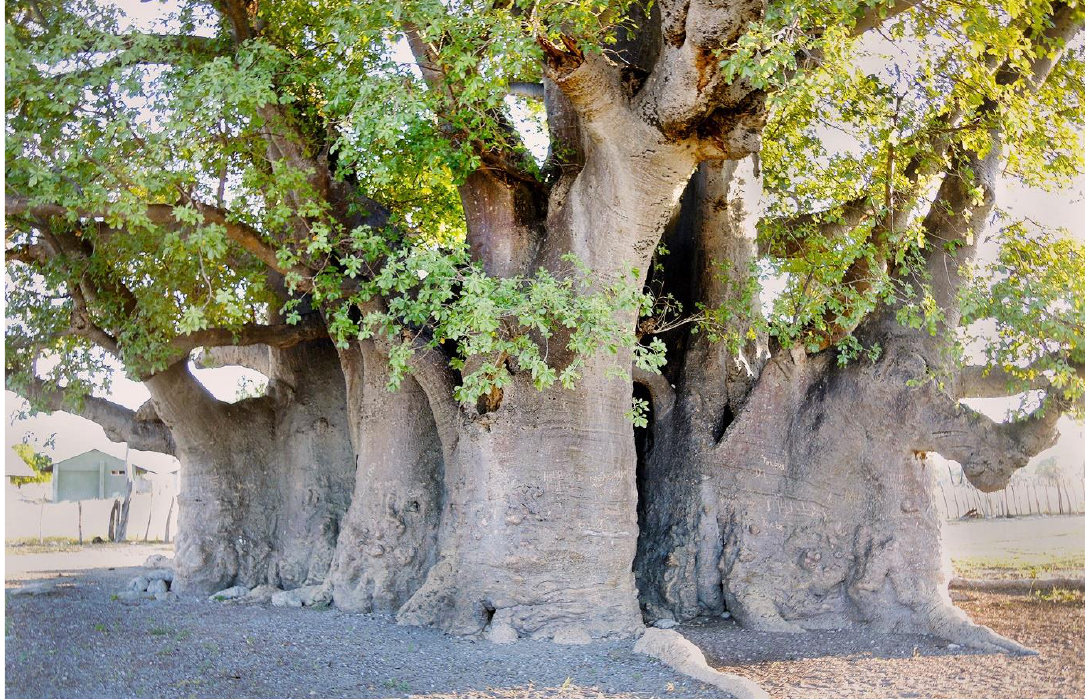
Figure 11. Another view of Sir Howard baobab taken from the west, showing to the right the two long false stems disposed in a V-shape.